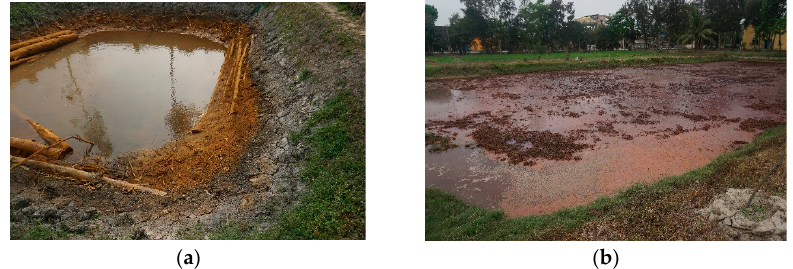
Figure 3. Adverse impact of acid sulphate soils on ecosystem: ( a ) Affected pond in the Bijoynagar village of Bali Island; ( b ) Cultivated soil with toxic effects of elements in Canning Block of South 24 Parganas. Source: Authors’ own collection from the farmers’ fields in the Indian Sundarbans region of the Ganges Delta.